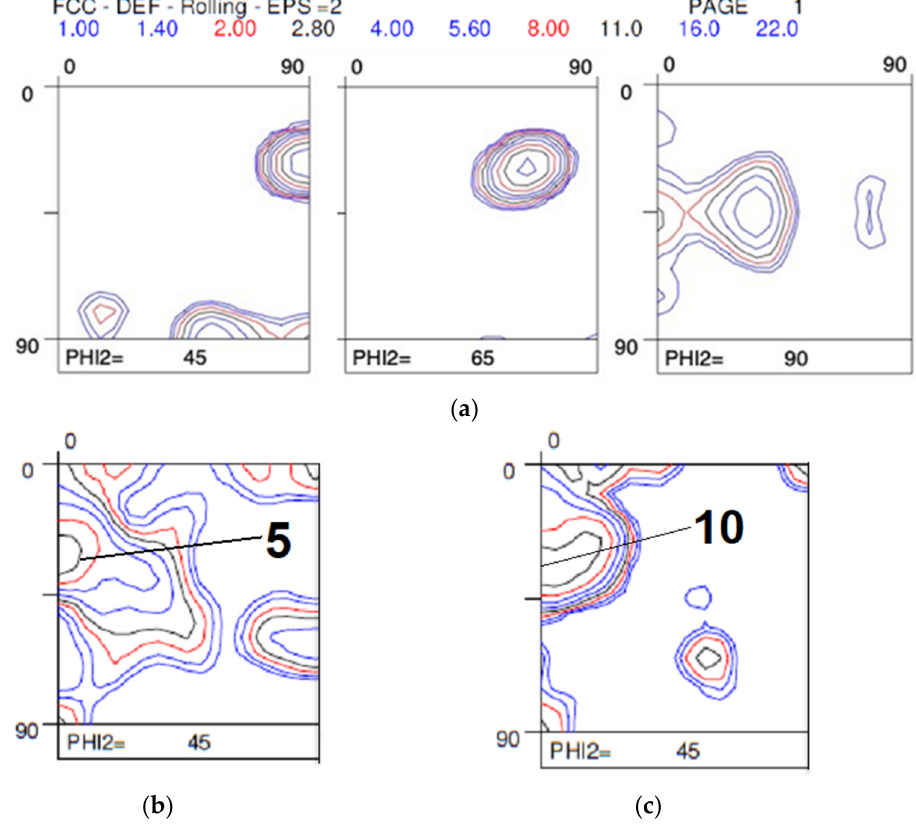
Figure 3. ( a ) Simulated FCC β fiber texture after a rolling reduction at true strain = 2; ( b ) the modeled BCC product texture without variant selection and ( c ) with double YKS variant selection.